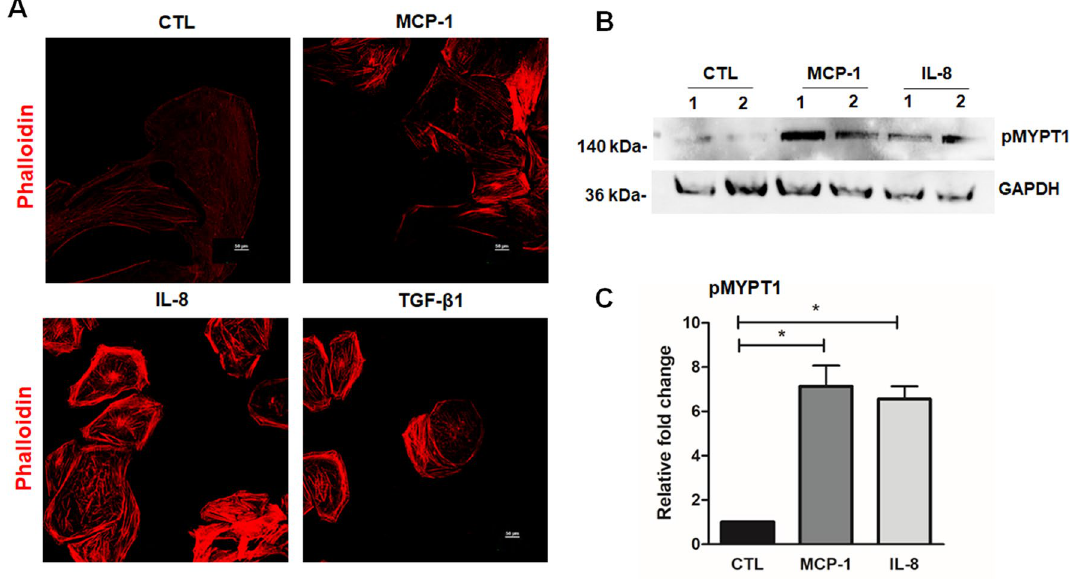
Figure 1. MCP-1 and IL-8 induces actin stress fibers and alters contractile properties of human TM cells. Primary cultured TM cells we generated were cultured on 2% gelatin-coated glass cover slips, serum-starved for 24 h and were treated with MCP-1 (100 ng/ml) or IL-8 (100 ng/ml) for 2 h or TGF-β 1 (10 ng/ml) for 24 h before staining for F-actin with TRITC-Phalloidin. Representative confocal images of stained cells show an increase in actin stress fibers (red) with MCP-1 and IL-8 treatment ( A ). MCP-1 and IL-8 treatment also revealed a significant increase in the levels of phosphorylated MYPT1 ( B , C ) relative to control (CTL) based on immunoblotting and densitometric analyses. Glyceraldehyde-3-phosphate dehydrogenase (GAPDH) was immunoblotted as a loading control for the cell lysates. The immunoblot data were normalized to GAPDH. Full-length blots/gels are presented in Supplementary Figure S1. * P < 0.05. N = 3, values are mean ± SEM and one-way ANOVA with Dunnett’s multiple comparison was done. MCP-1 monocyte chemoattractant